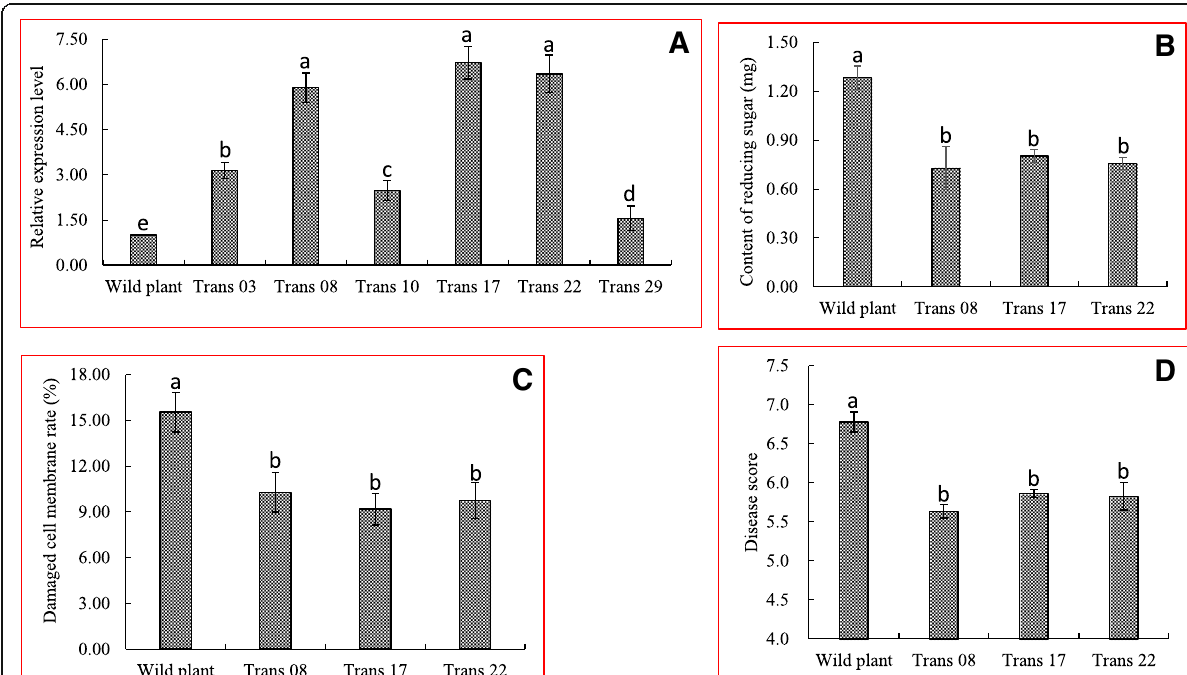
Fig. 6 Analysis of transgenic lines expressing OsPGIP2 L233F . a , Relative expression level of OsPGIP2 in wild-type cv. XD 3 and the six transgenic lines (Trans 03, 08, 10, 17, 22, and 29) containing OsPGIP2 L233F . b , Content of reducing sugars in wild-type and transgenic rice lines (Trans 08, 17, and 22); seedlings were immersed in a solution containing RsPGs. c , Cell membrane damage (%) as measured by electrical conductivity in wild-type and transgenic plants (%). d , Disease rating scores in wild-type and transgenic lines inoculated with R. solani YN-7. Different lowercase letters on the column show significant statistical difference between treatment and control at 5% significance level. Each bar represents the average and standard deviation of at least three